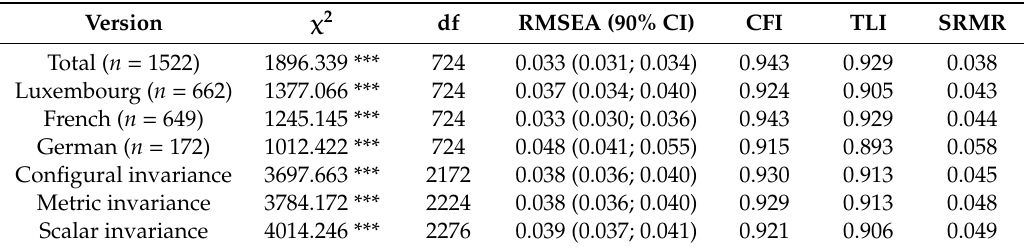
Table 4. Fit indices for single CFAs and measurement invariance across language version.